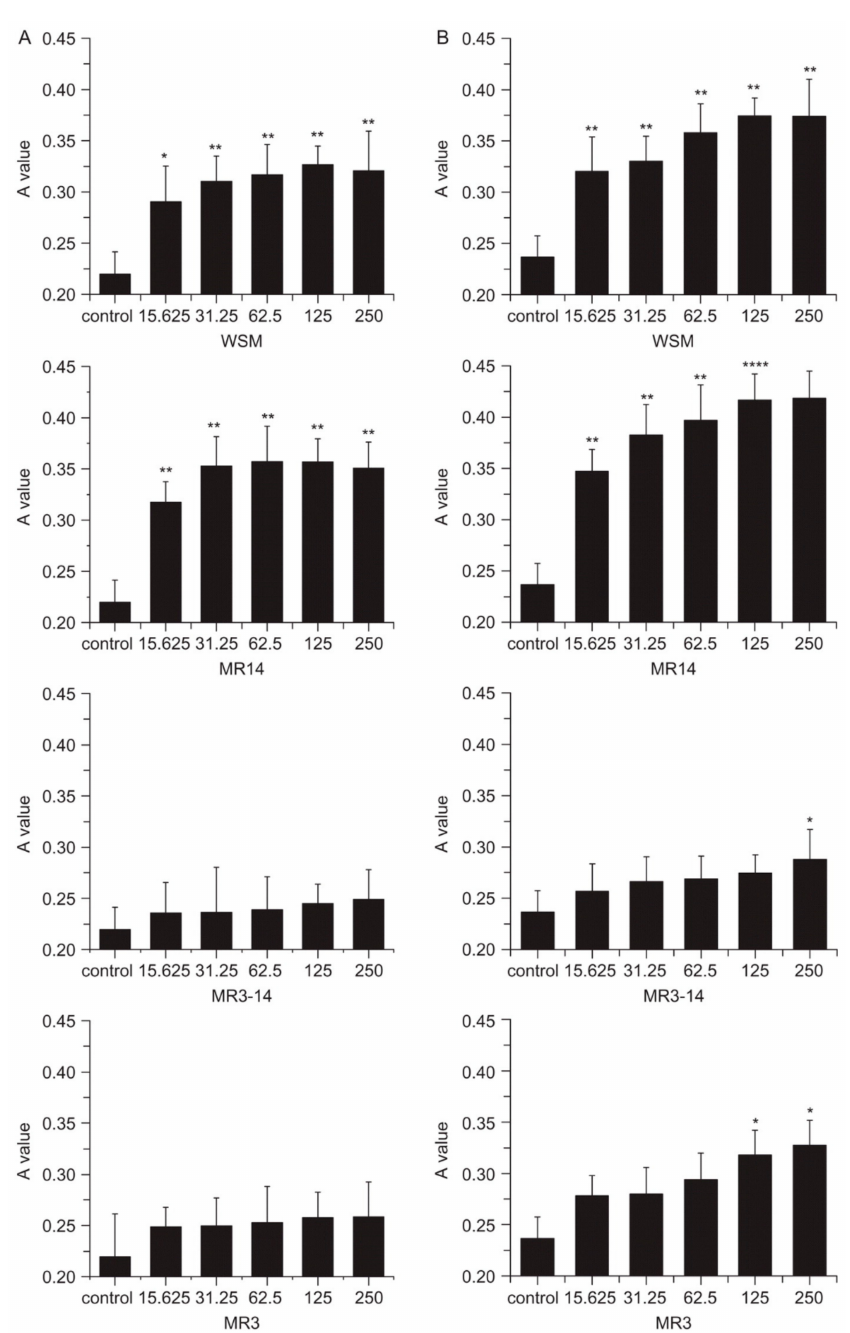
Figure 2. The water-soluble matrix (WSM) was extracted from pearl powder and size-fractionated using a 14 kDa cut-off dialysis tubing to give >14 kDa retentate (MR14), followed by a 3 kDa tubing dialysis to give 3–14 kDa retentate (MR3-14) and <3 kDa retentate (MR3). Effects of WSM, MR14, MR3–14, and MR3 on the growth of fibroblasts ( µ g/mL): incubation ( A ) after 2 days and ( B ) after 3 days. Reproduced from [49]. * p <0.05; ** p <0.01; **** p